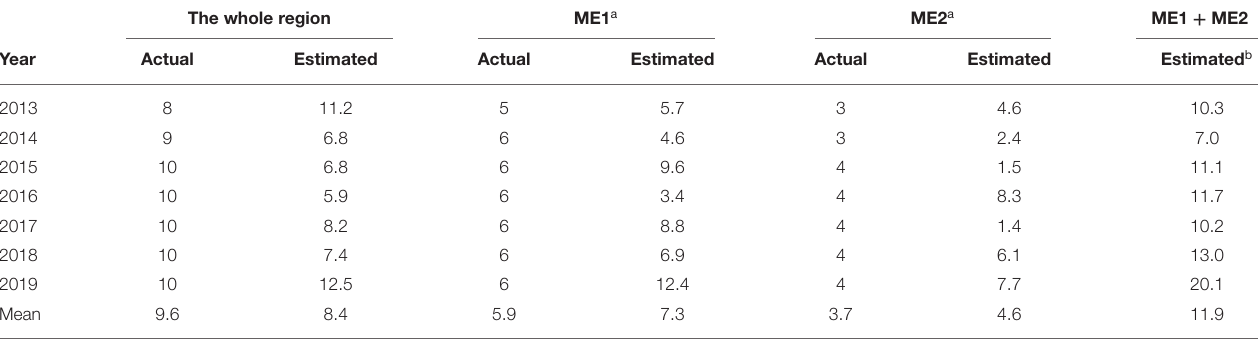
TABLE 3 | The estimated minimum number of locations in comparison to that actually used for the Quebec provincial oat trials. The whole